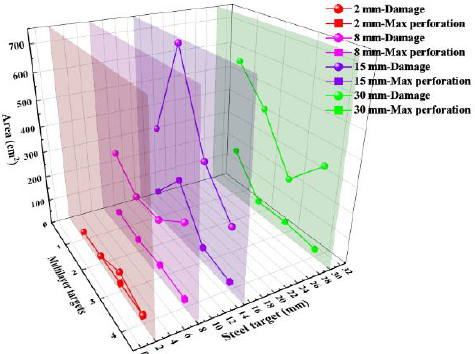
Figure 6. Comparison of MLAT target damage effects for different thicknesses of the RHA steel target.